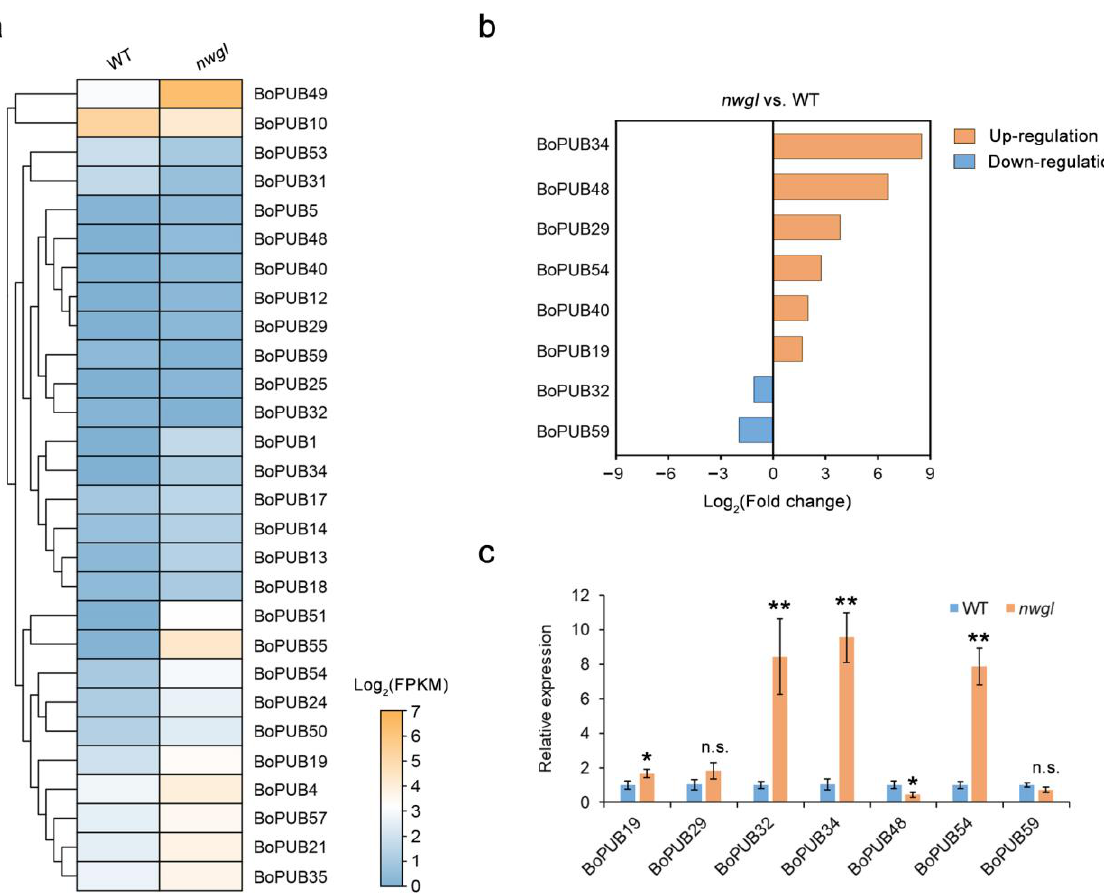
Figure 7. Differential expression of BoPUB genes between wild type and nwgl mutant. ( a ) Expression profiles of BoPUB genes in wild type and nwgl mutant. The normalized expression data, as fragments per kilobase per million mapped reads (FPKM), of BoPUB genes in wild type (WT) and nwgl leaves were obtained from the RNA-seq data of cabbage ( Brassica oleracea var. capitata ). The expression levels of BoPUB genes were plotted in a log2-scaled heatmap. Each row in the color heatmap indicates a single gene, and their names are shown. ( b ) Differentially expressed BoPUB genes in nwgl relative to its wild type. The expression data (FPKM) of BoPUB genes were obtained from the RNA-seq data of nwgl and its wild type (WT). Fold changes in the expression levels of BoPUB genes were shown in a log2-scaled histogram. Gene names are shown on the y-axis, and the log2-transformed fold changes in gene expression levels are shown on the x-axis. Orange bars represent up-regulated BoPUB genes, and blue bars represent down-regulated BoPUB genes. ( c ) The relative expression of BoPUB genes in wild type and nwgl mutant. Total RNA was extracted and submitted to quantitative real-time PCR. The BoTUB6 gene was used as the internal control. Error bars represent the means ± standard deviation (SD) of three independent experiments. Asterisks indicate significant differences (* p < 0.05, ** p < 0.01; two-tailed Student’s t -test). n.s., not